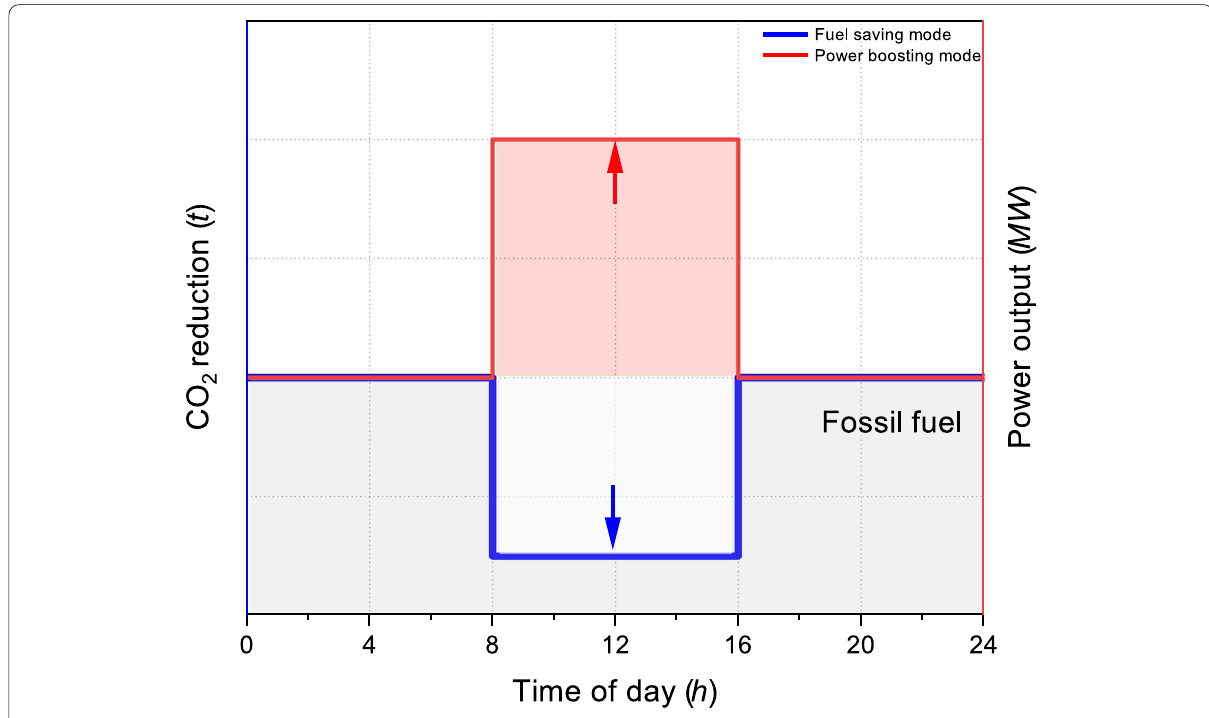
Fig. 25 Operating modes for renewables integrated with fossil fuelled power system